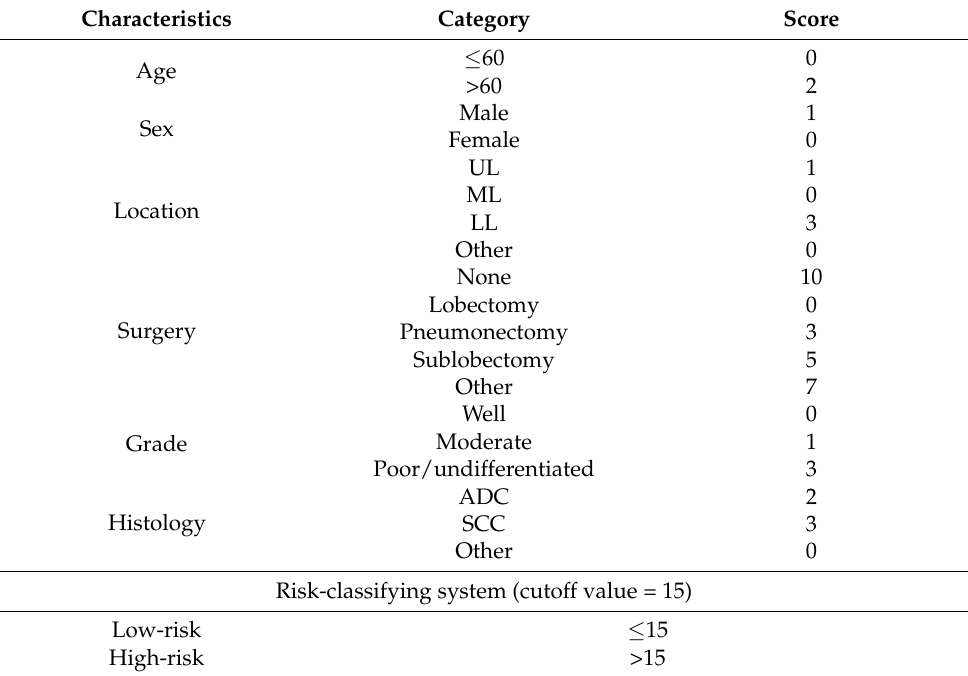
Figure 3. Nomogram for predicting the 3-year and 5-year overall survival in occult NSCLC patients. UL, upper lobe; ML, middle lobe; LL, low lobe; ADC, adenocarcinoma; SCC, squamous cell carcinoma. Table 3. Prognostic score of each covariate calculated based on the